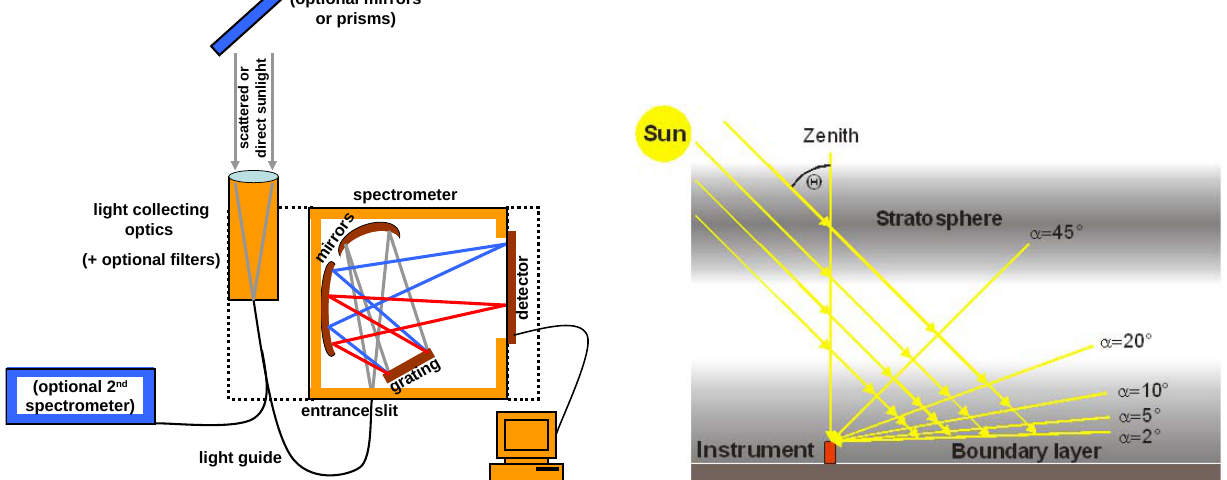
Fig. 4. Left panel: MAX-DOAS instrument layout. The dashed box indicates that the three components (optics, spectrometer, detector) can be separate units or included in the same housing. Right panel: MAX-DOAS viewing geometry. The participating MAX-DOAS instruments measured at different elevation angles consecutively; tropospheric information can be retrieved using the fact that the light path through the stratosphere is almost constant as a function of elevation angle. The scanning is performed by rotating either a mirror or prism, or the optical head or telescope, or the whole